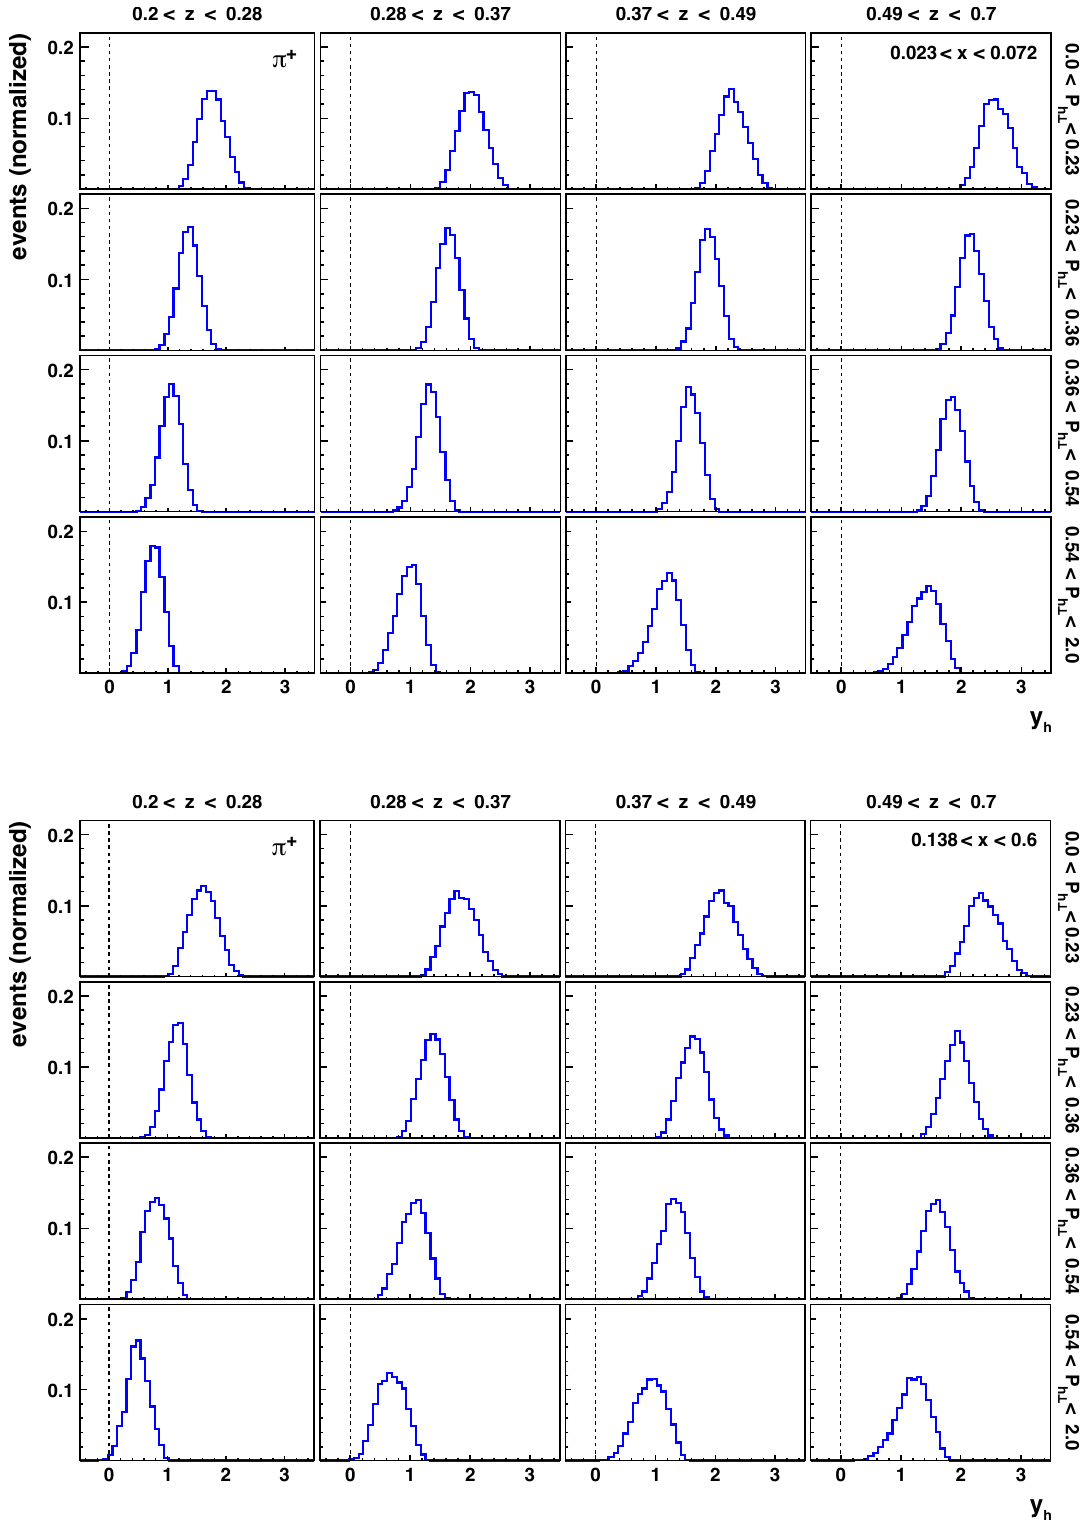
Figure 43 . Rapidity distributions for π + in the various ( z , P h ⊥ ) bins of the first (top) and last (bottom) x bins. The dashed lines indicate zero